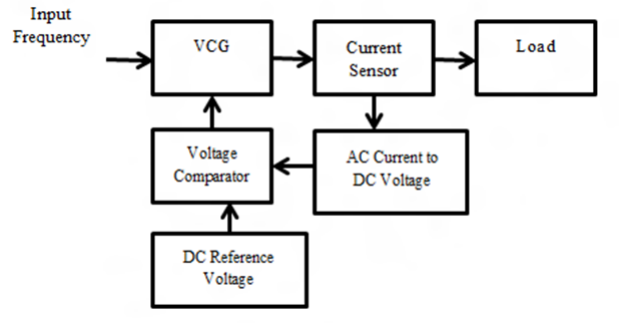
Fig. 3: Block Diagram for the complete